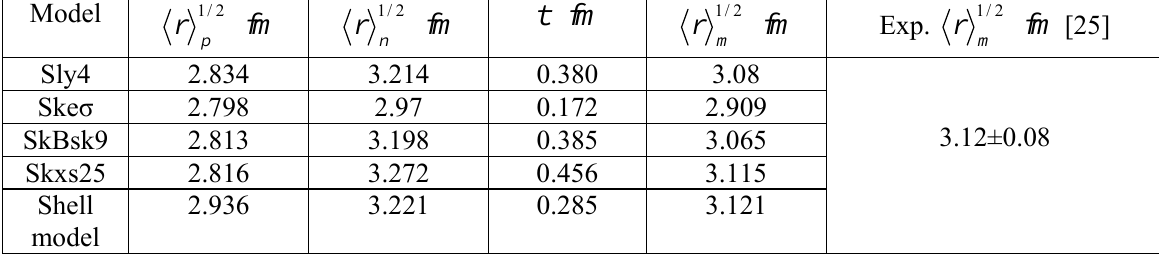
Table 3: The values of rms radii in fm of 25 F nucleus.